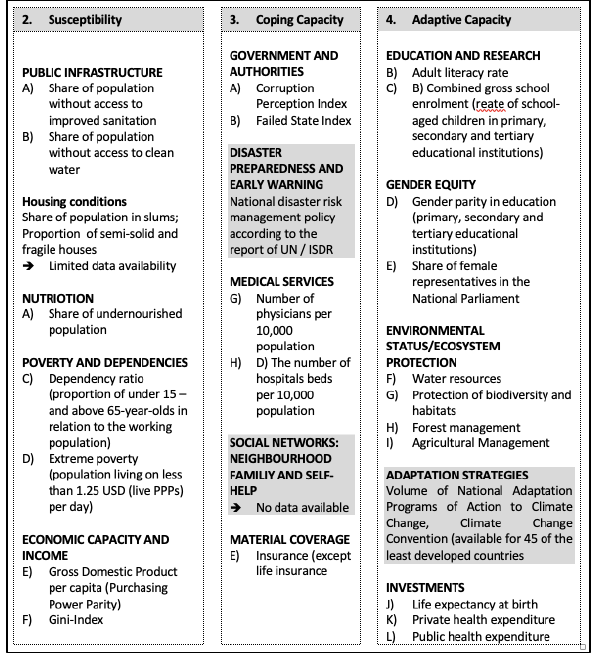
Table 1. Concept of the World Risk Index (Welle & Birkmann